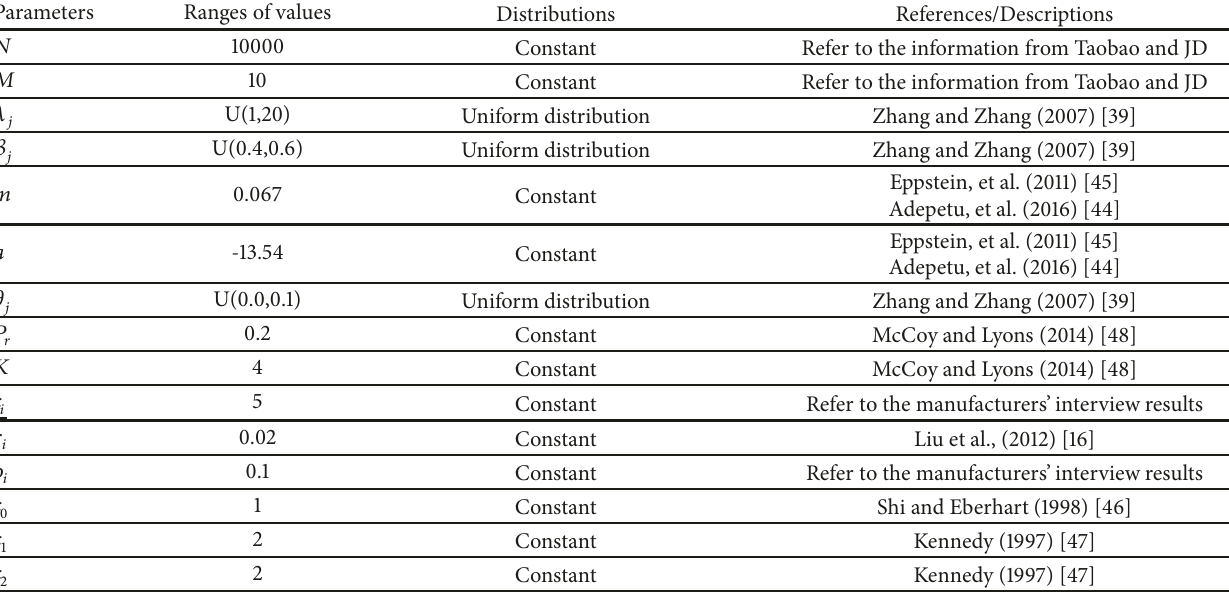
Table 1: The initial value-setting of the basic parameters of the